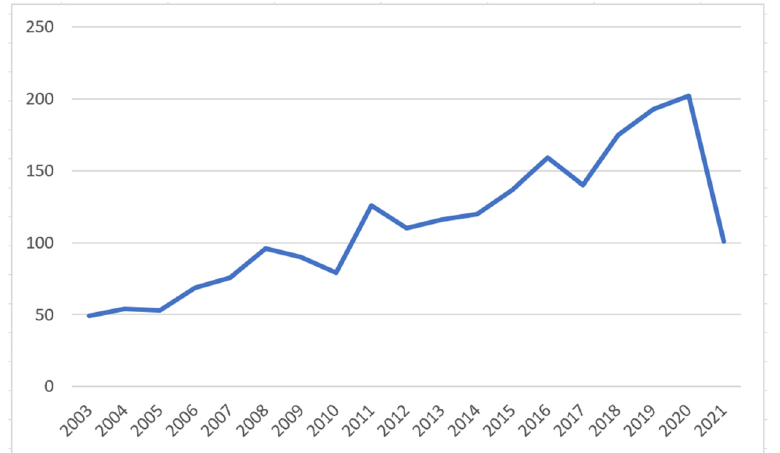
Figure 1. Number of CBR articles published in the medical and health fields over time.